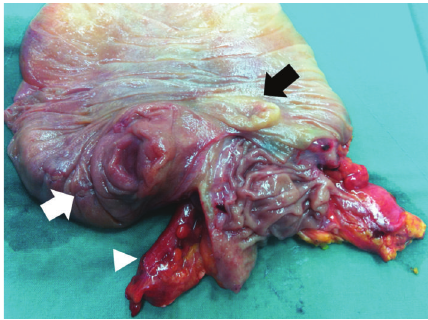
Figure 2: Resected specimen showing a hard, mass-like lesion in thececumbase(whitearrow:mass-likelesion;blackarrow:ileocecal valve; white arrowhead: